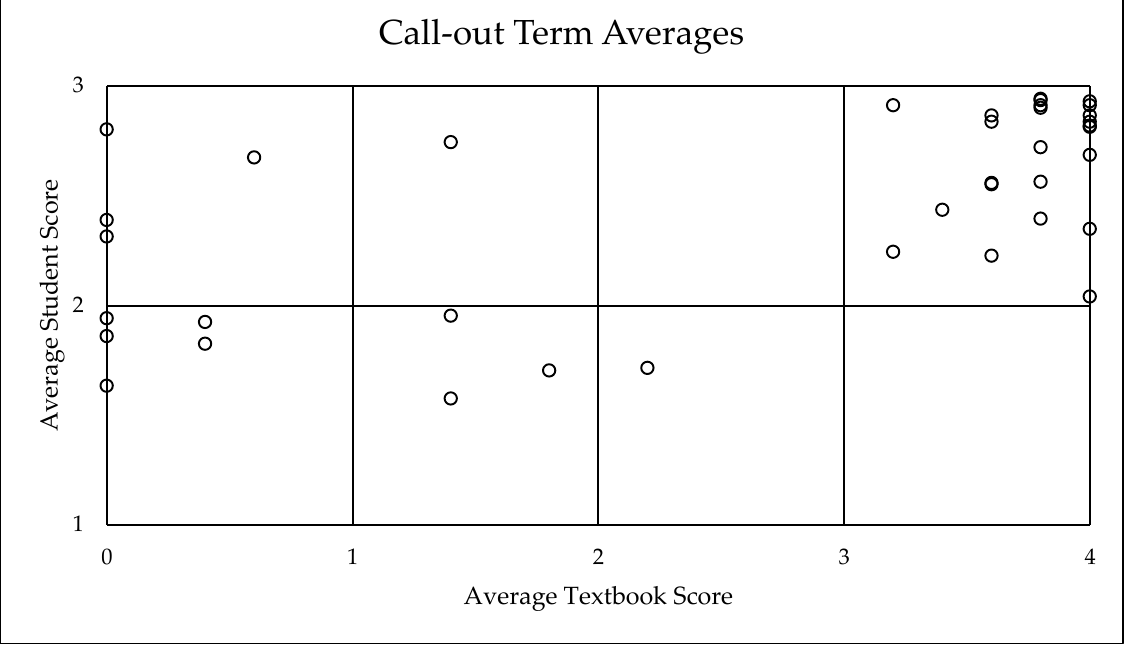
Figure 4. Textbook scores. Depicted are the results after evaluating five introductory physical geology textbooks to better understand the extent to which the 38 call-out terms from the upper-division rifting video are discussed. See text for further discussion.